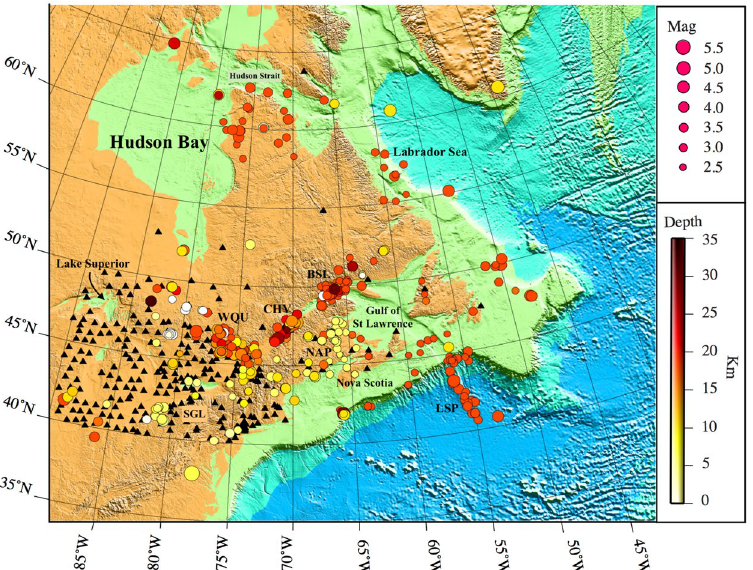
Figure 2. Distribution of events (circles) and stations (black triangles) used for the Q estimation. Circles are scaled based on earthquake magnitudes and color coded based on event depths. Major seismic zones in the region are marked on the map: Southern Great Lakes Seismic zone (SGL), Western Quebec Seismic Zone (WQU), Charlevoix Seismic Zone (CHV), Lower St. Lawrence seismic Zone (BSL), Northern Appalachians Seismic Zone (NAP), and Laurentian Slope Seismic Zone (LSP). The figure is generated from GMT, which is an open source software available at: http://gmt.soest.hawaaii.edu.